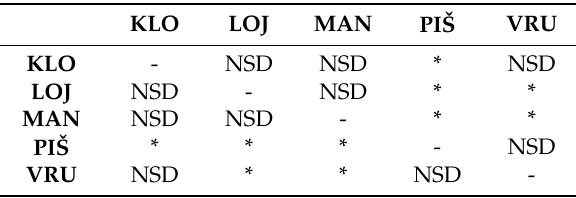
Table 2. Results of the t-test for the δ 13 C org values of the sediments (NSD = no statistical significance,* = statistical significance at a confidence level of p ≤ 0.05).